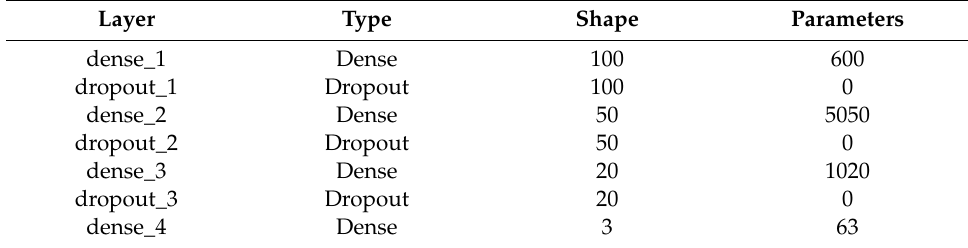
Table 2. Trained parameters with dense and dropout layers using the TensorFlow framework with Keras for hourly wind turbine